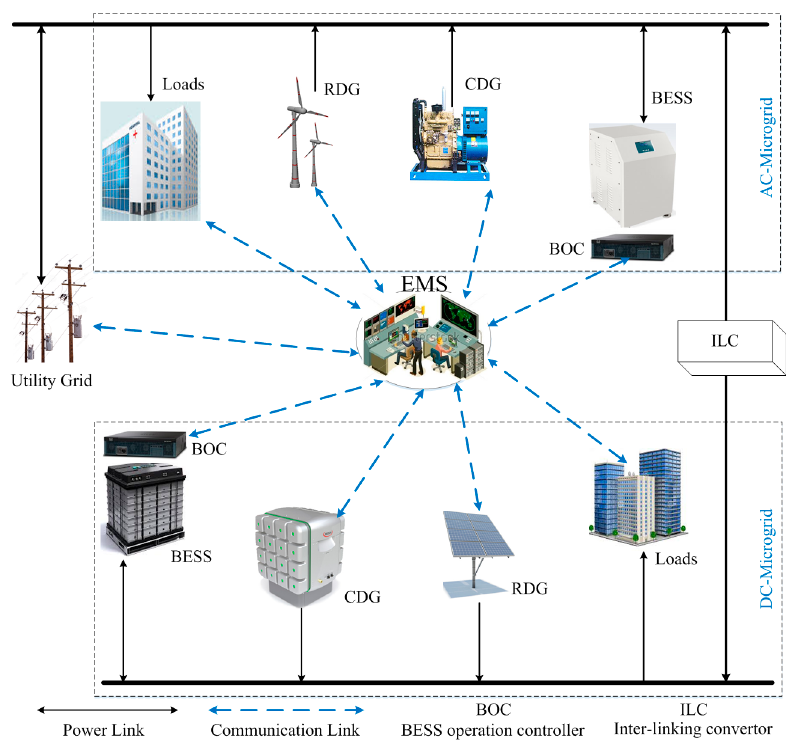
Figure 1. An illustration of a typical hybrid microgrid system.